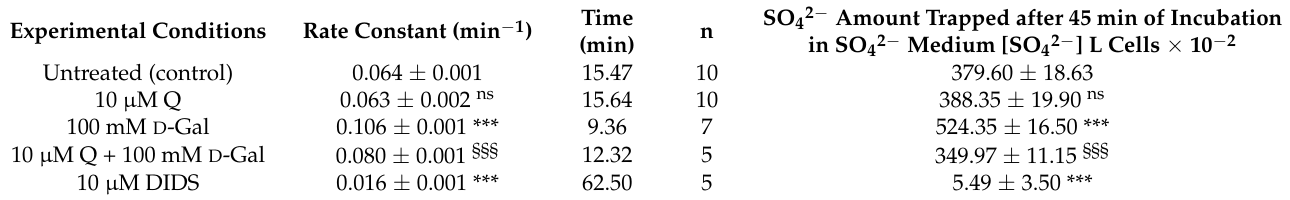
Figure 3. Time course of SO 42 − uptake in erythrocytes left untreated (control) or treated with 10 µ M Q, 100 mM D -Gal with or without pre-exposure to 10 µ M Q, or 10 µ M DIDS. ns, not statistically significant versus control; ***, p < 0.001 versus control; ◦◦◦ , p < 0.001 versus 100 mM D -Gal-treated erythrocytes, one-way ANOVA followed by Bonferroni’s post hoc test. Table 1. Rate constant of SO 42 − uptake and amount of SO 42 − trapped in untreated (control) erythro- cytes and erythrocytes treated as indicated. Data are presented as means ± S.E.M. from separate (n) experiments, where ns, not statistically significant versus untreated (control); ***, p < 0.001 versus control, §§§ , p < 0.001 versus 100 mM D -Gal-treated erythrocytes, one-way ANOVA followed by Bonferroni’s multiple comparison post hoc